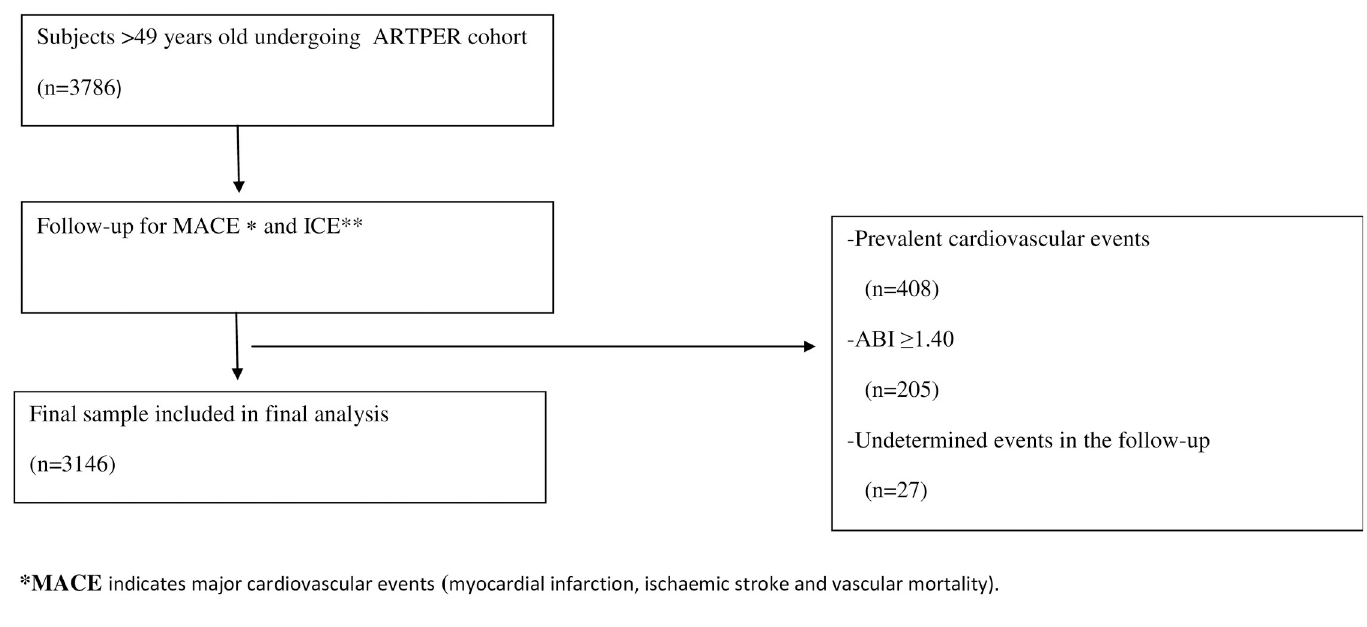
Fig 1. Flow-chart of study